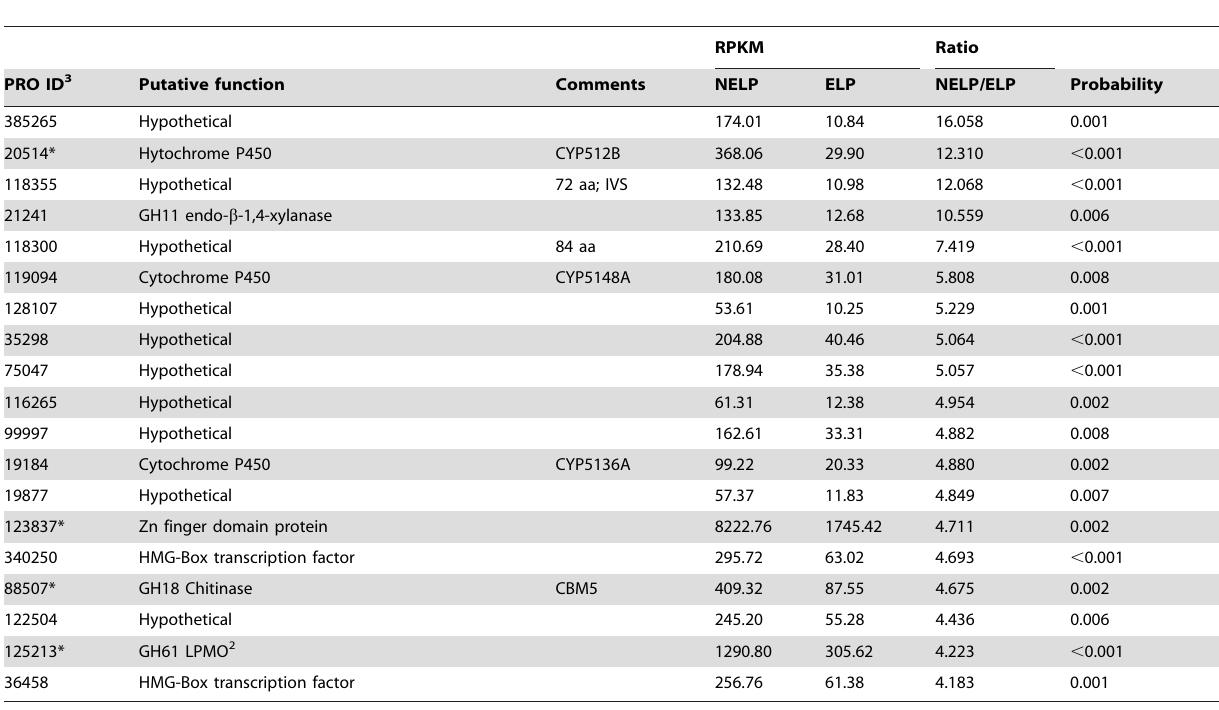
Table 2. Transcripts accumulating . 4-fold in non-extracted loblolly pine wood (NELP) relative to extracted loblolly pine wood (ELP). 1